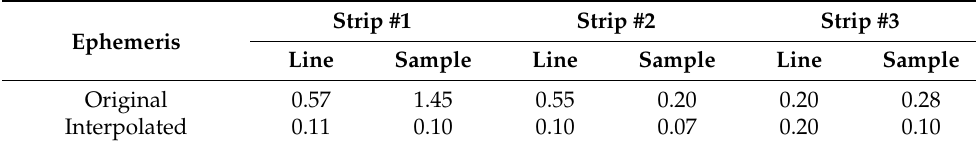
Figure 6. Difference between the original and the interpolated roll angles (Strip #1). Table 2. RPCs conversion residual in RMSE (unit: pixels).